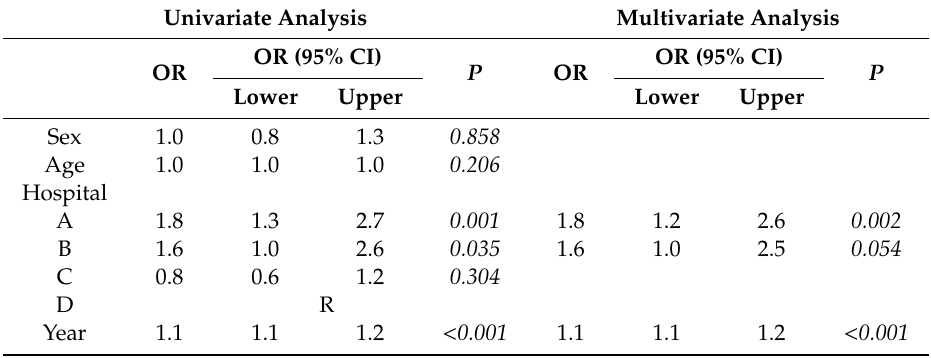
Table 3. Multivariate analyses on factors associated with an increased risk for infection with an ESBL-producing uropathogen. Univariate Analysis Multivariate Analysis OR (95% CI) OR (95% P OR OR